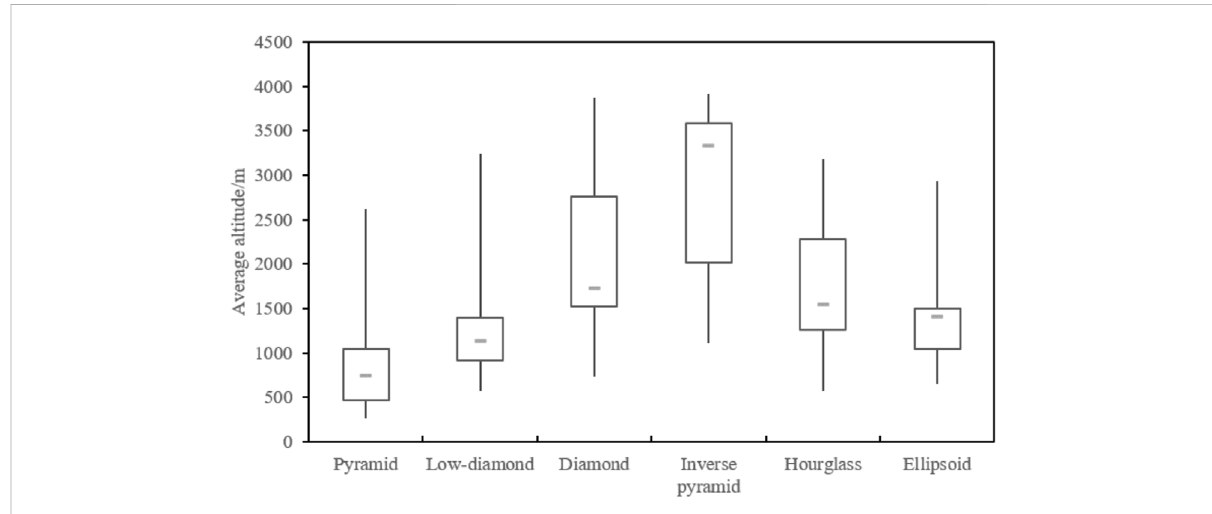
FIGURE 10 Average elevation ranges of different mountain structure types in the Qinling-Daba